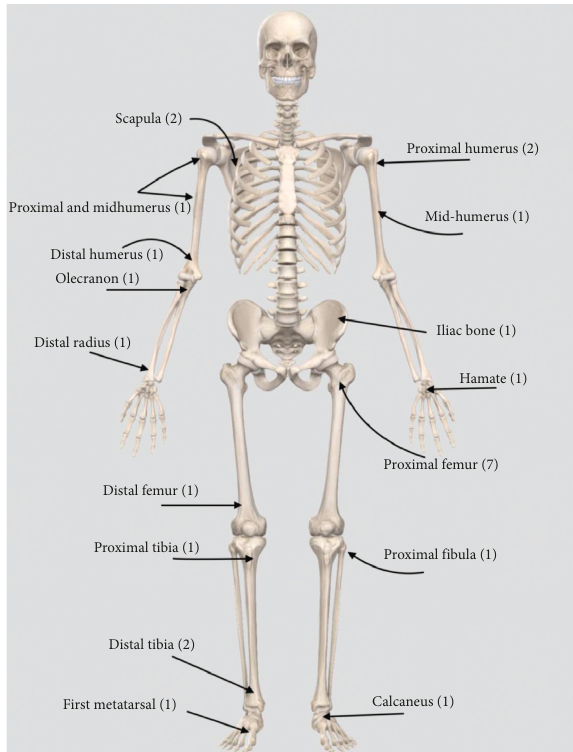
Figure 3: Anatomical distribution of aneurysmal bone